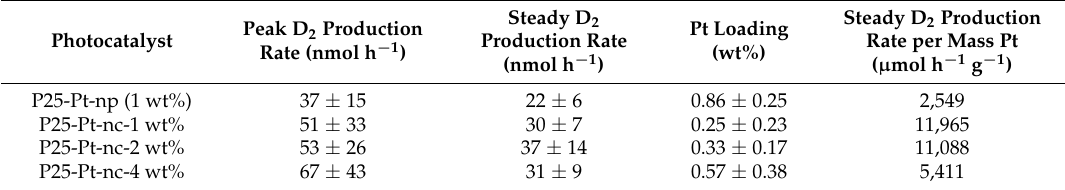
Figure 6. Box and whisker plots of steady D 2 production rate for photocatalysts tested.